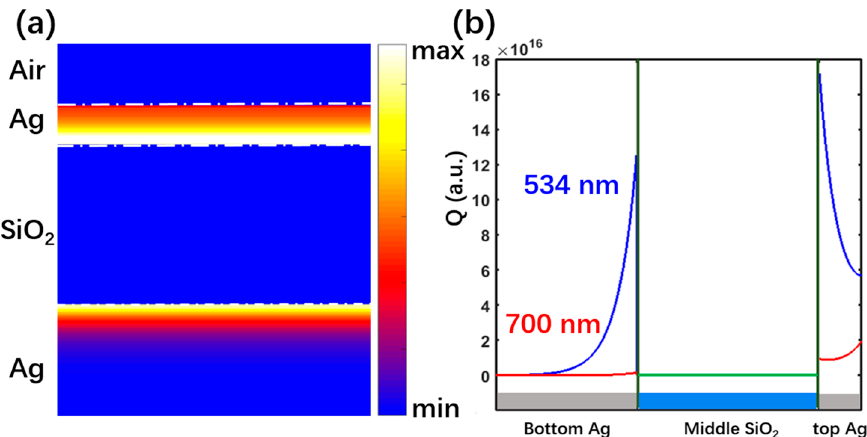
Figure 5. ( a ) Simulated energy distribution at the 534 nm resonance wavelength when the middle SiO 2 layer is 130 nm; and ( b ) the Ohmic loss calculated by Equation (1) at the resonance wavelength and non-resonance wavelength.